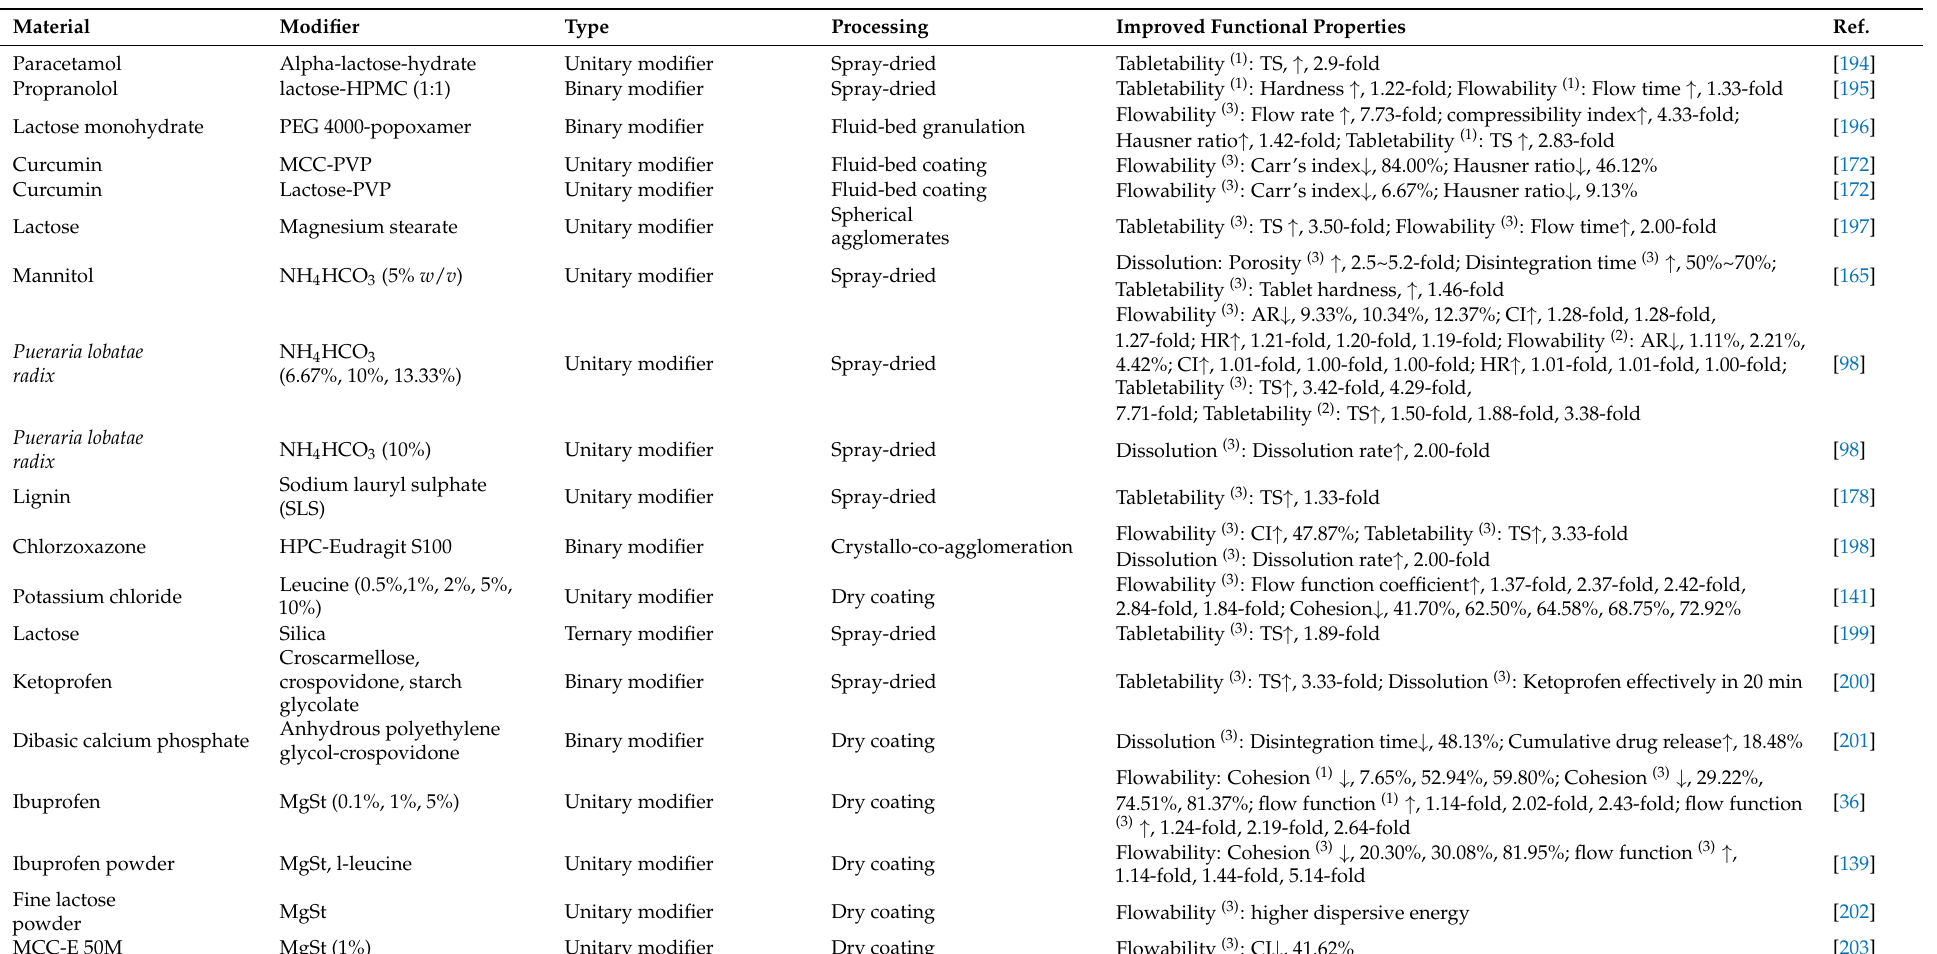
Table 5. The application of other